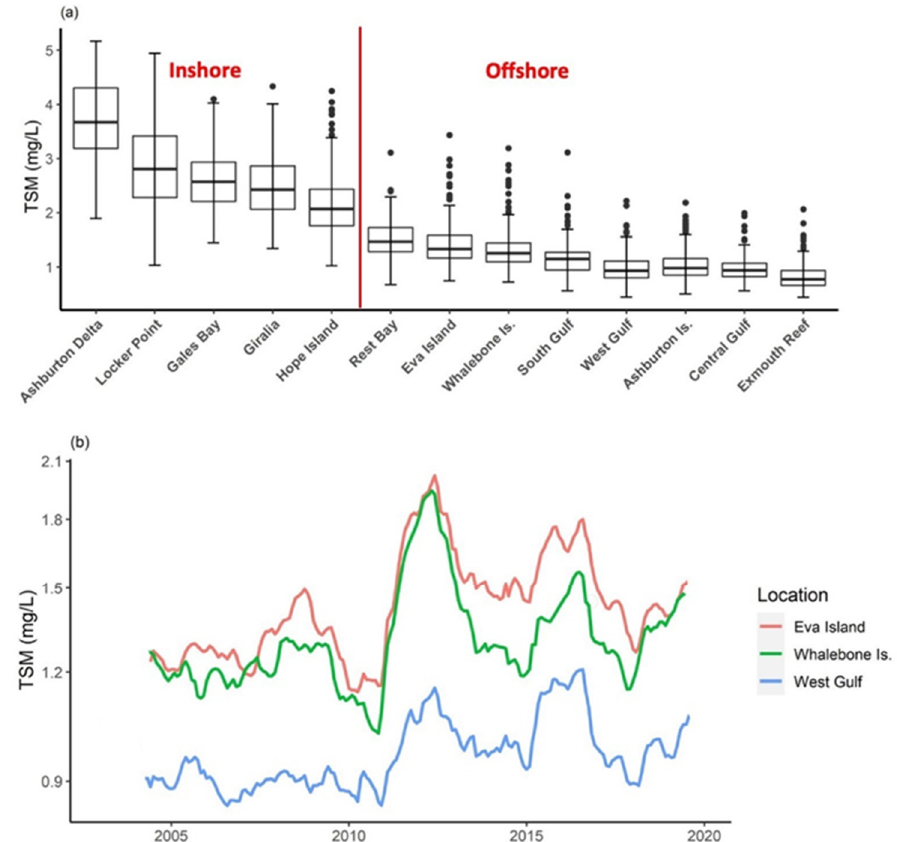
Figure 4. ( a ) Monthly total suspended matter (TSM) variability at 13 locations in the Exmouth Gulf between 2002 and 2020 showing median, interquartile ranges, max/min, and outliers; offshore refers to locations more than 3 nautical miles from the coastline. ( b ) TSM time series (18-month rolling mean) at three locations where there was an increasing trend of monthly average TSM from 2002 to 2020 (modified Mann–Kendall p < 0.05).